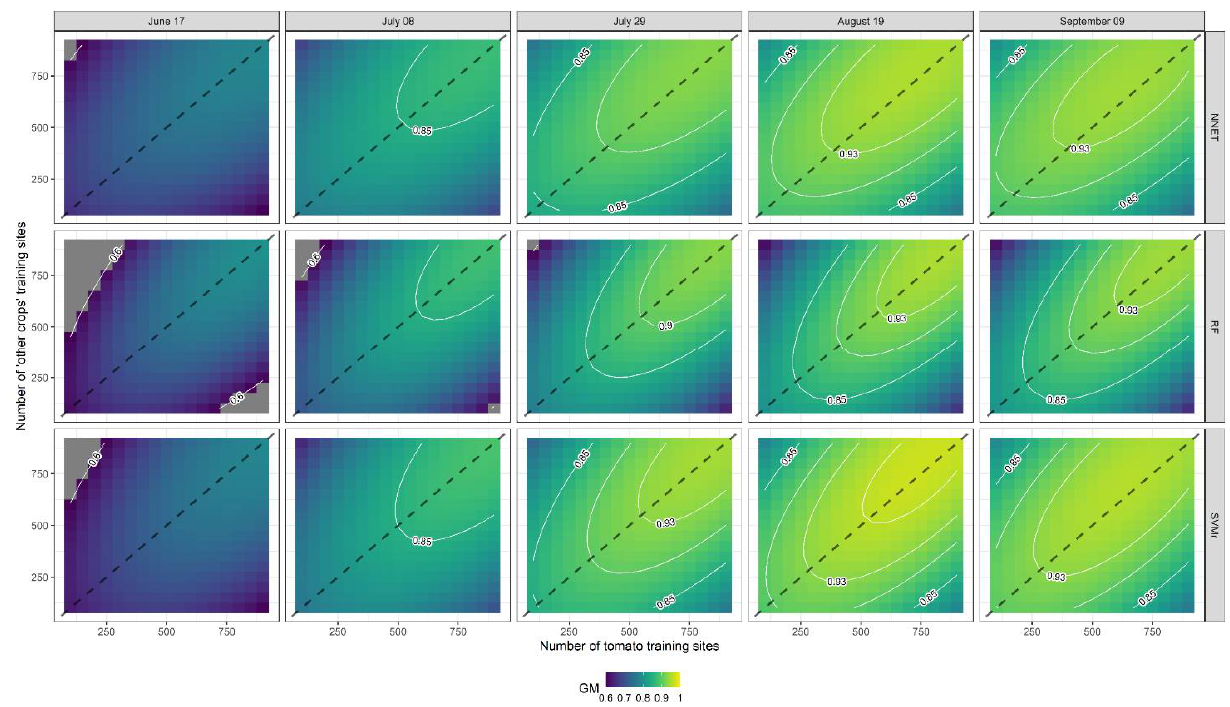
Figure 7. Response contour plots for G-Mean (GM) as a function of the number of tomato training sites (X 1 ) and the number of ‘other crops’ training sites (X 2 ). The dashed line represents a 1:1 line between X 1 and X 2 .